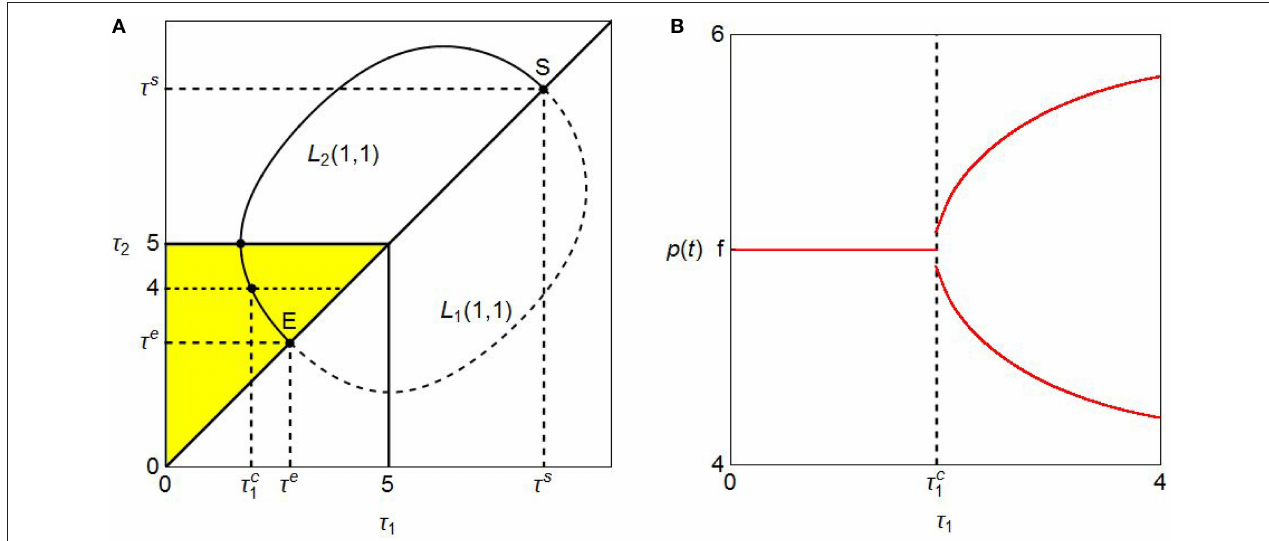
FIGURE 4 | Dynamics for α 1 = 6 / 15 and α 2 = 1 / 3: (A) Stability region, (B) Bifurcation diagram.